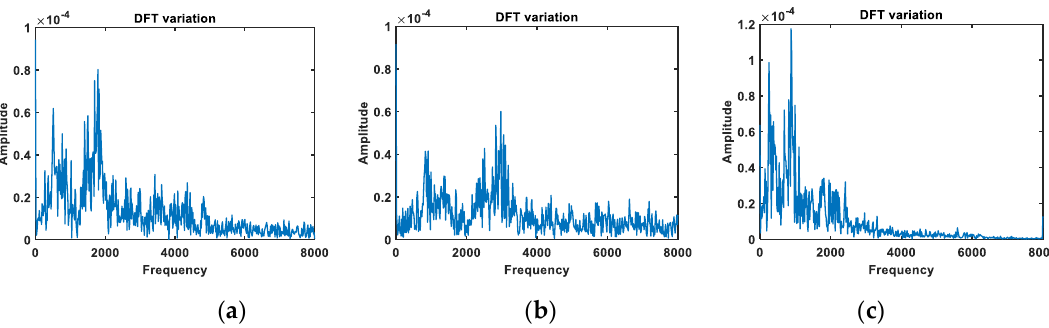
Figure 1. Discrete Fourier transform (DFT) amplitude spectra of ( a ) the original speech, ( b ) the resampled speech with p/q = 0.5, and ( c ) the resampled speech with p/q = 2.